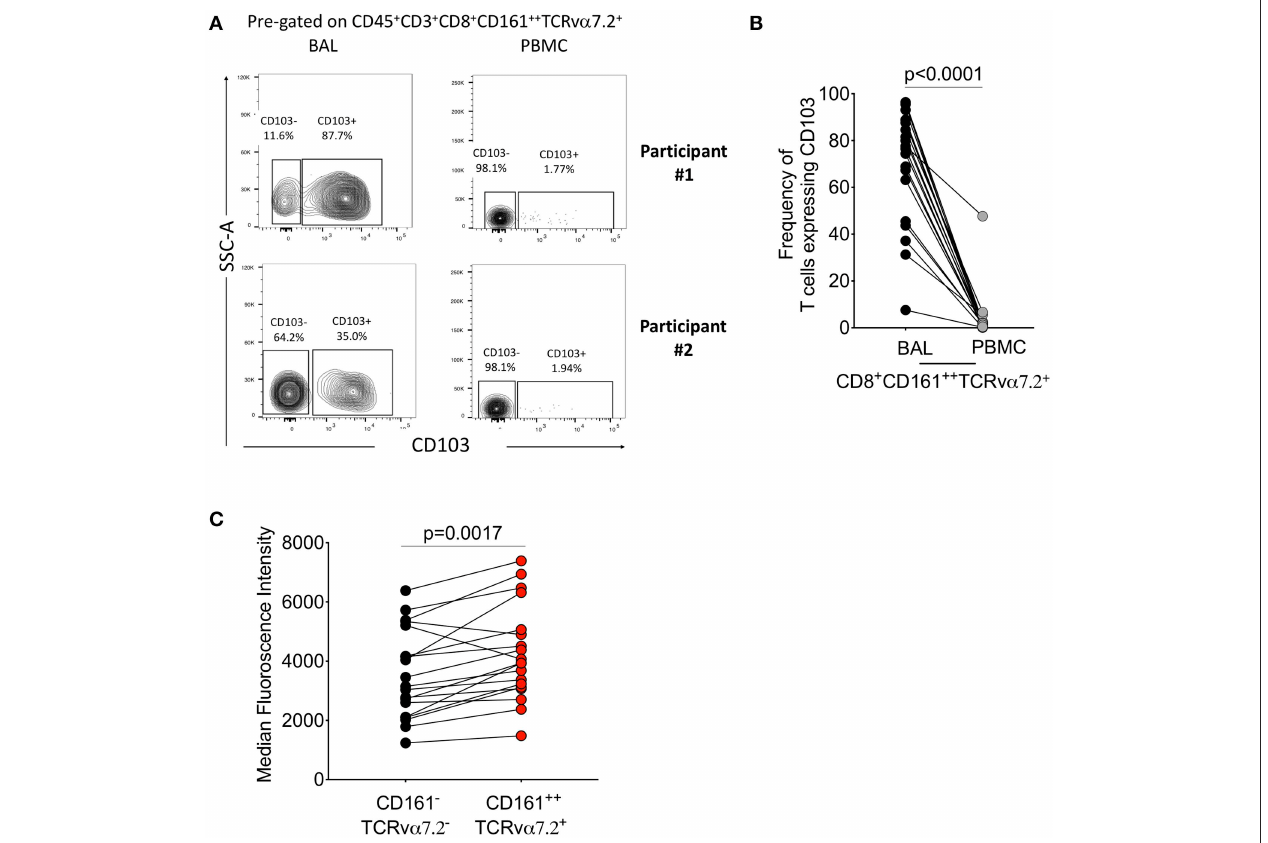
FIGURE 2 | Characterization of CD8 + CD161 ++ TCRv α 7.2 + T cells in airway lumen and peripheral circulation. BAL cells and PBMCs from HIV-uninfected adults were stained with fluorochrome-conjugated antibodies against surface markers of interest. (A) Representative flow cytometry plots showing CD103 expression in CD8 + T cells in matched BAL and PBMC samples from two healthy HIV-uninfected adults. (B) Proportion of CD103 expressing CD8 + CD161 ++ TCRv α 7.2 + T cells in BAL and PBMCs. (C) CD103 expression intensity in CD8 + CD161 ++ TCRv α 7.2 + T cells compared to classical CD8 + T cells from the airway lumen. Data were analyzed using Wilcoxon matched-pairs signed rank test ( n = 19). BAL, bronchoalveolar lavage; PBMC, peripheral blood mononuclear